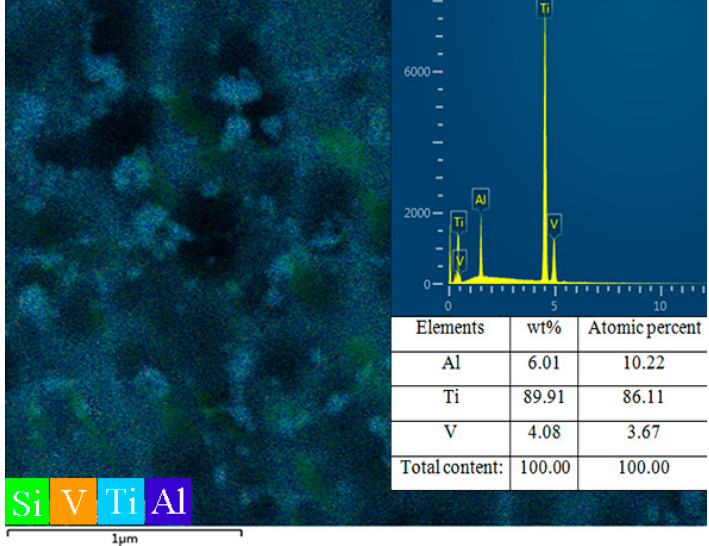
Figure 2. The EDS analysis of the sample surface after 120 min SMAT.